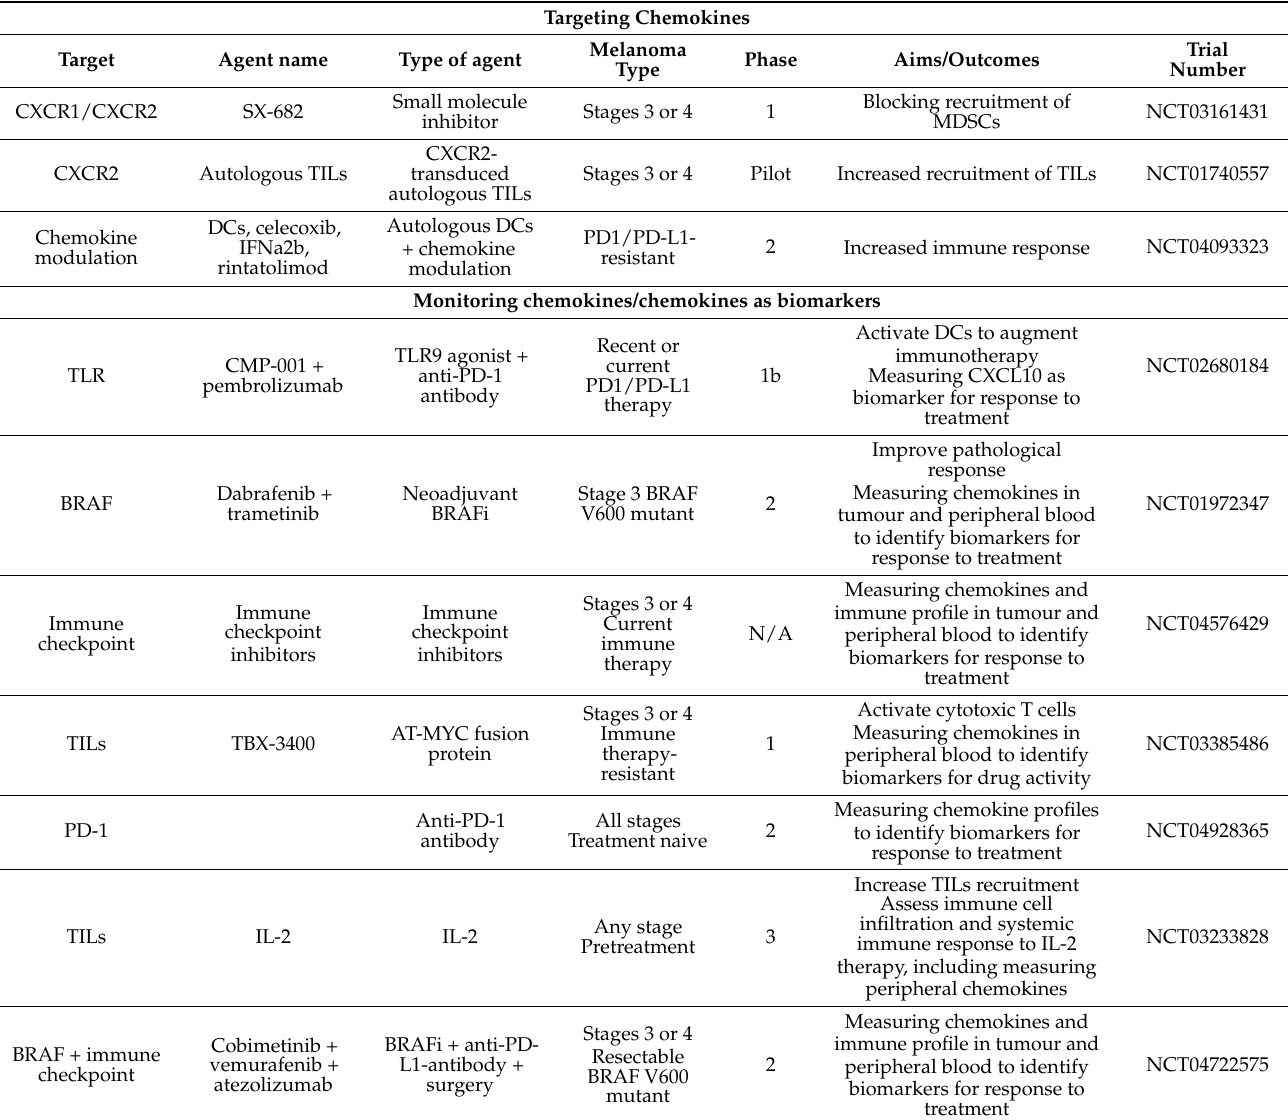
Table 2. Current clinical trials targeting and monitoring chemokines in